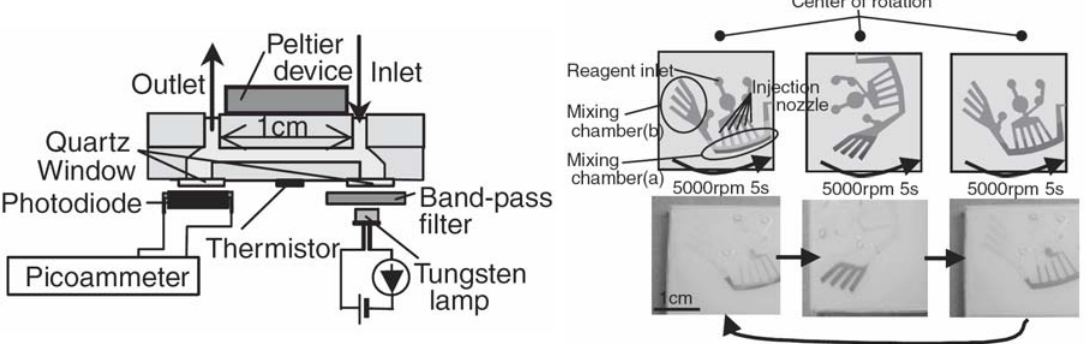
Figure 1. ( Left ) Cross-sectional illustration of the chip for measurement of γ -GTP, GOT and GPT. ( Right ) Illustrations and photographs of actual operation of mixing chip